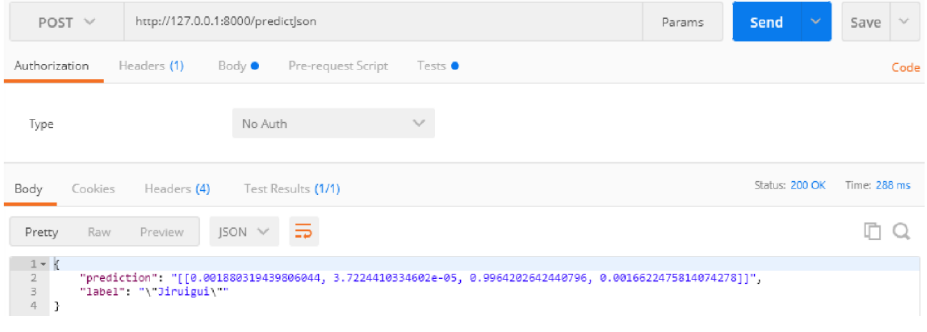
Table 4. Summary of HTTP Inference response time